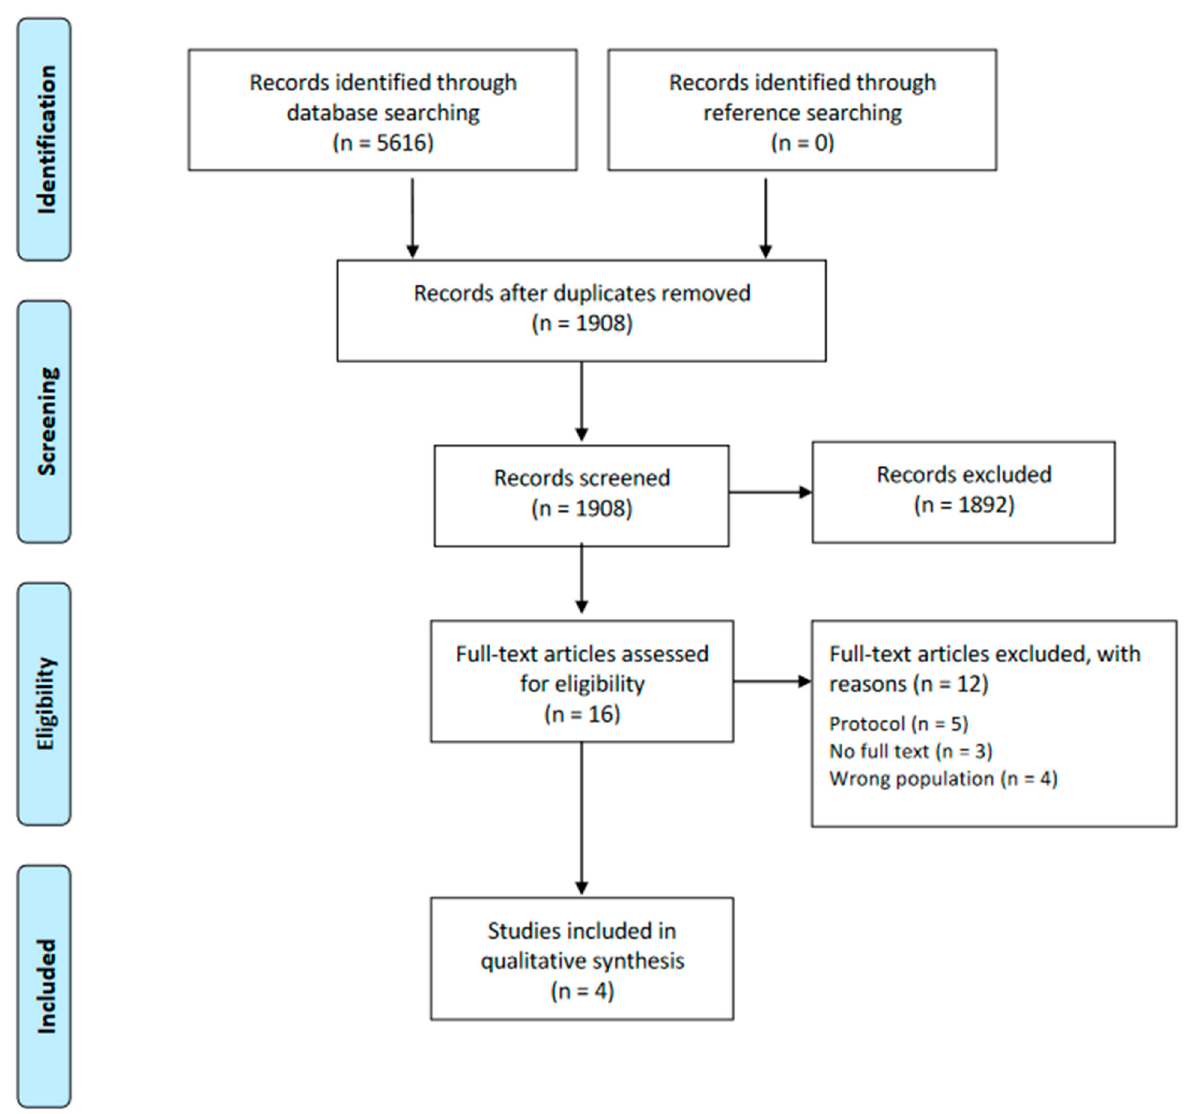
Figure 1. Flow diagram of the eligibility process.